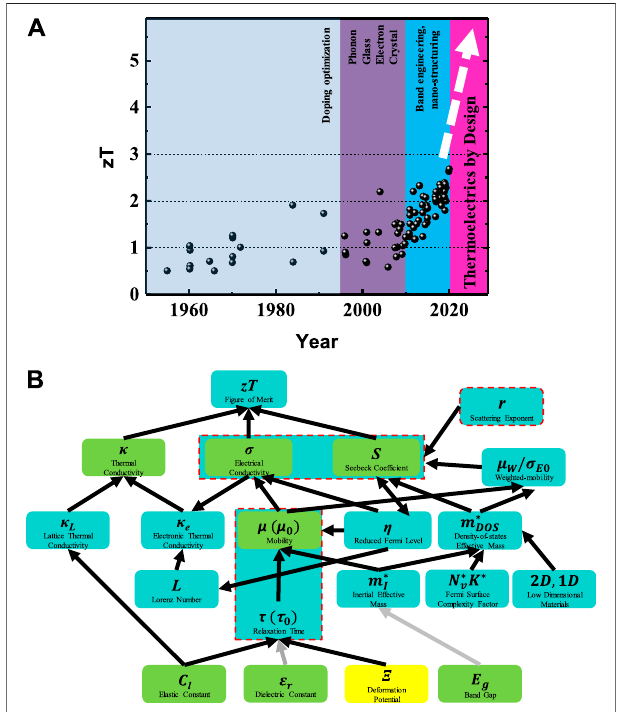
FIGURE1|(A) Progressiveoverviewofthermoelectricperformanceasa function to the timeline in years and correlations of zT components. (B) Tree diagram showing the complex web of interdependencies between electronic transport parameters that make up zT .